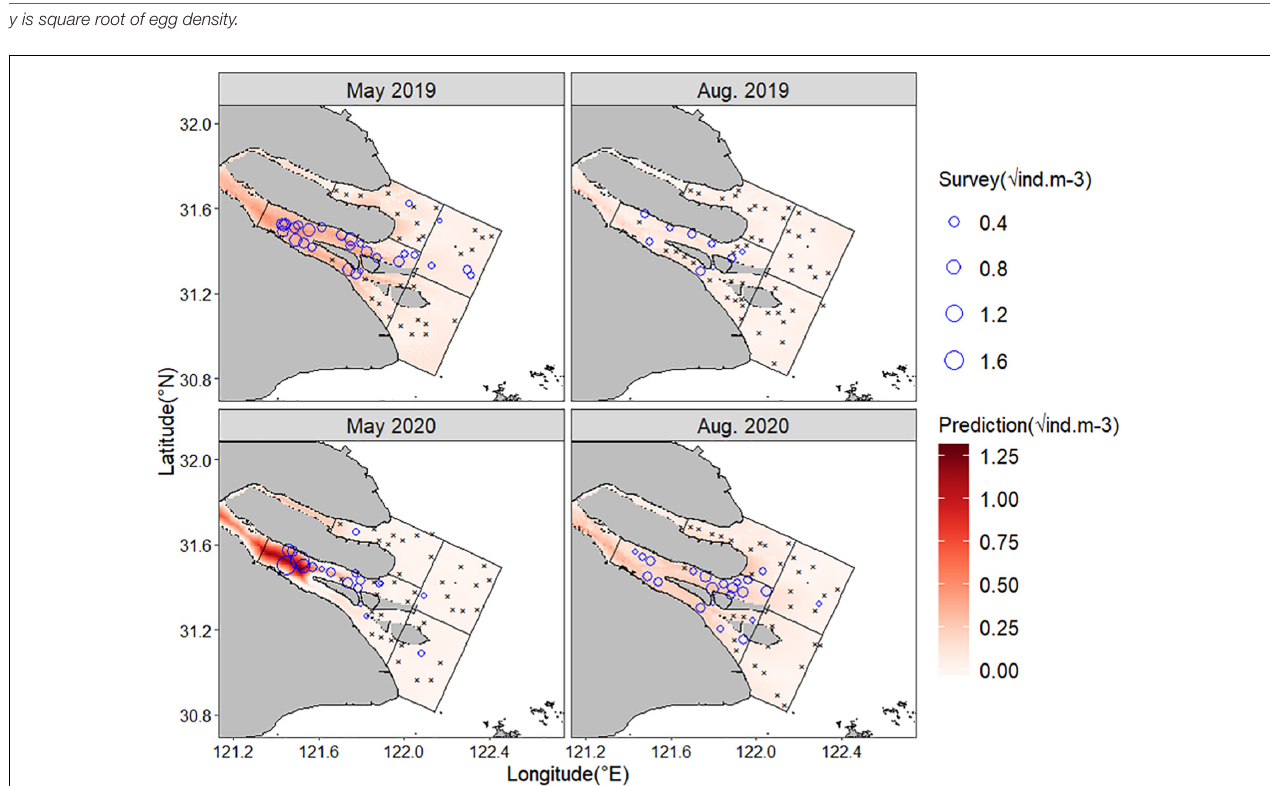
FIGURE 3 | The distribution of eggs sampled and predicted in each survey. The blue circle is egg density sampled in each station and the black × denotes stations with zero egg sampled. The color gradation represents the prediction result.